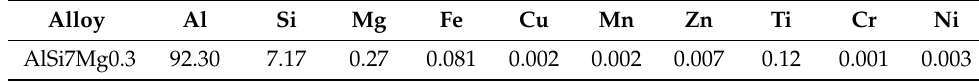
Table 3. Composition of AlSi7Mg0.3 aluminum alloy (in wt